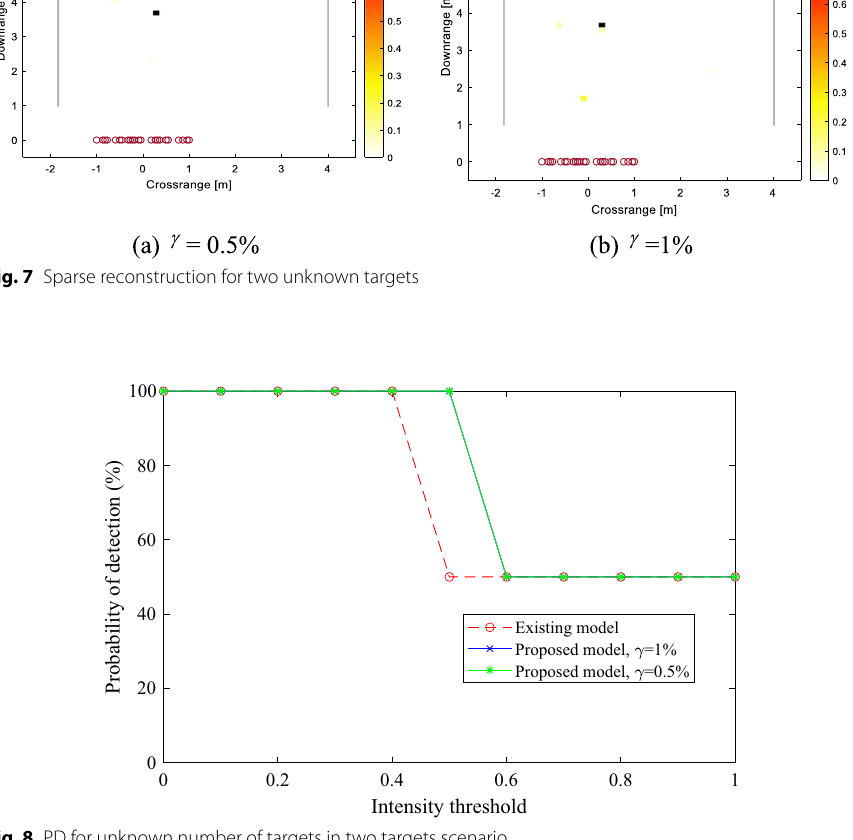
Fig. 8 PD for unknown number of targets in two targets